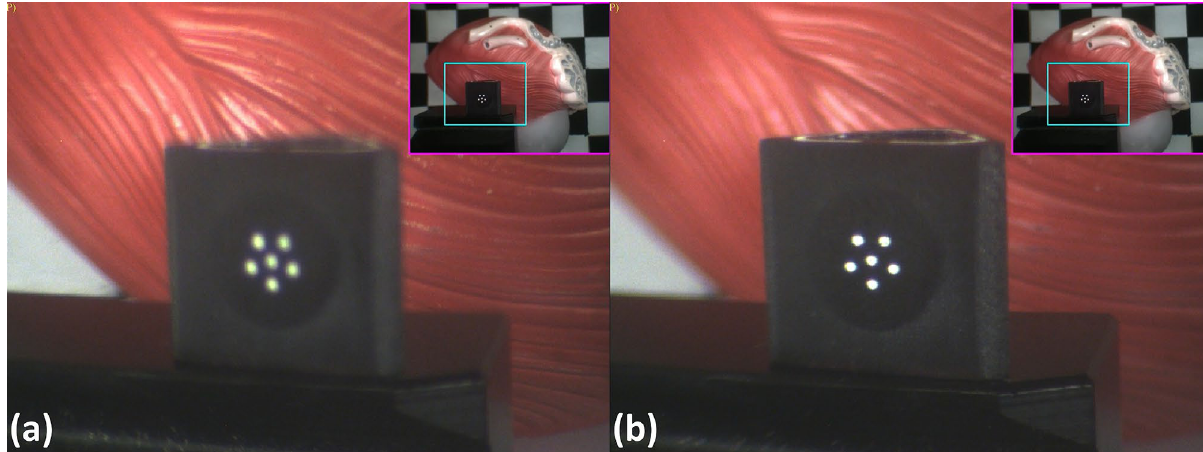
Figure 13. Demonstration of MRFL focus profiles. The profiles are calibrated at working distances of ( a ) 150 mm and ( b ) less than 50 mm. A bladder analogue and die were placed at those working distances respectively. The images shown were captured in quick succession without changing the setup or touching the camera. As intended, cycling through the focus profiles alternates focus between ( a ) the bladder analogue and ( b ) the die. This feature is also demonstrated in Supplementary Video